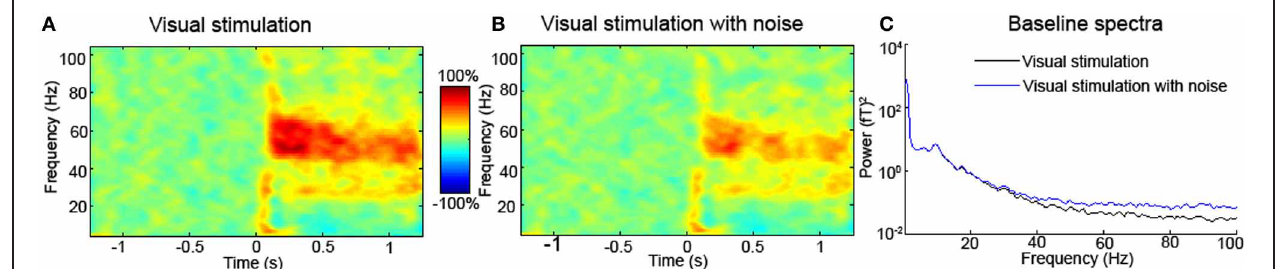
FIGURE 1 | (A) Typical MEG source-level time-frequency response of a single participant to visual stimulation with a square-wave grating stimulus (data from Muthukumaraswamy et al., 2013). Equivalent EEG data look very similar (Muthukumaraswamy and Singh, 2013). In the time-frequency spectrum presented in (B) , white noise has been added to the channel prior to computation of the time-frequency response. The high-frequency response around 60Hz is clearly attenuated in the presence of white noise, which similar to muscle activity has a broad bandwidth. Similar to this artificial addition of simulated noise, any experimental intervention (or use of different participant groups) that modulates baseline noise levels